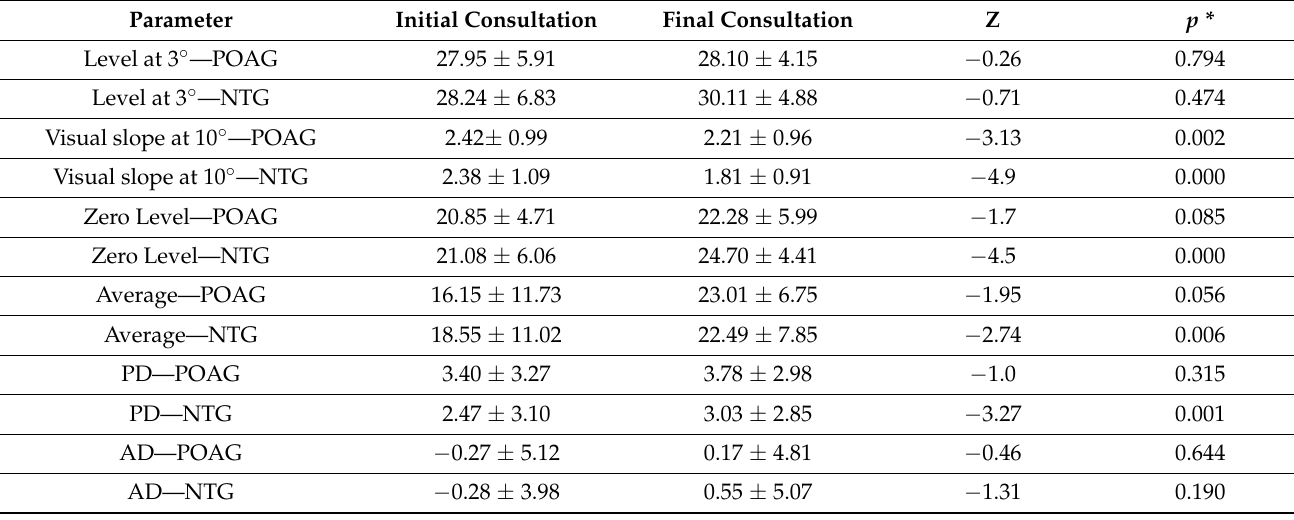
Table 6. Distribution of the parameters “Visual field” of the patient with POAG and